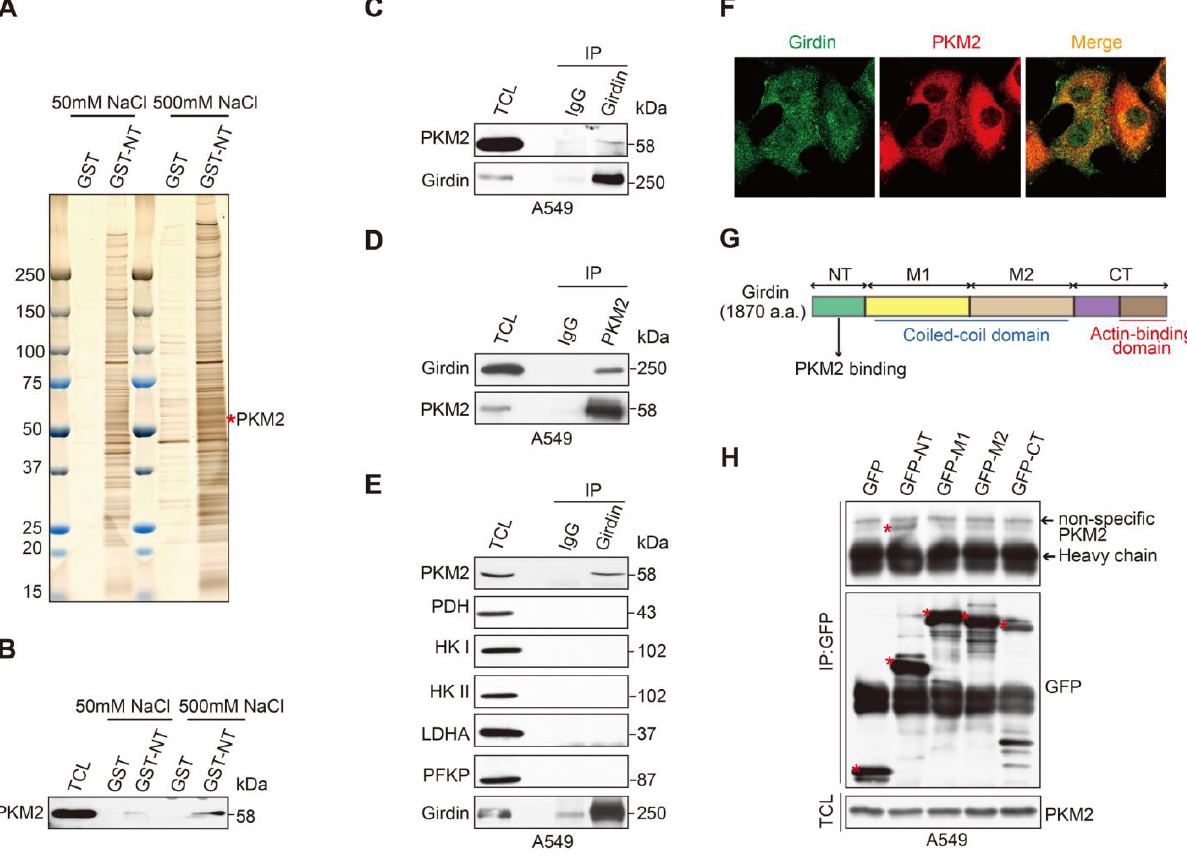
Figure 4. Identification of PKM2 as a Girdin-interacting protein. ( A ) Girdin-interacting proteins were isolated by purification from E. coli and visualized with silver staining. ( B ) Direct interaction between Girdin and PKM2 by GST pull-down assay. ( C , D ) Endogenous IP using control IgG and anti-Girdin or anti-Flag antibody was carried out in A549 cells, showing that Girdin interacts with PKM2 in the LUAD cell line. ( E ) Co-immunoprecipitation (co-IP) was performed in A549 cells to screen the Girdin-interacting proteins from key enzymes of glycolysis. ( F ) Representative confocal images of Scheme 2 in A549 cells. Girdin was detected using an anti-Girdin primary antibody and Alexa Fluor 488 goat anti-mouse antibody, and PKM2 was detected using an anti-PKM2 primary antibody and Alexa Fluor 594 goat anti-rabbit antibody. ( G ) Domain structure of human Girdin protein. The N-terminal (NT) domain is responsible for the interaction with PKM2. ( H ) PKM2 interacts with Girdin by binding to its NT domain. Lysates from 293FT cells transfected with the Girdin fragments fused with GFP were immunoprecipitated with the anti-GFP antibody, followed by WB analyses using the PKM2 antibody. Bound PKM2 is indicated by a red asterisk.